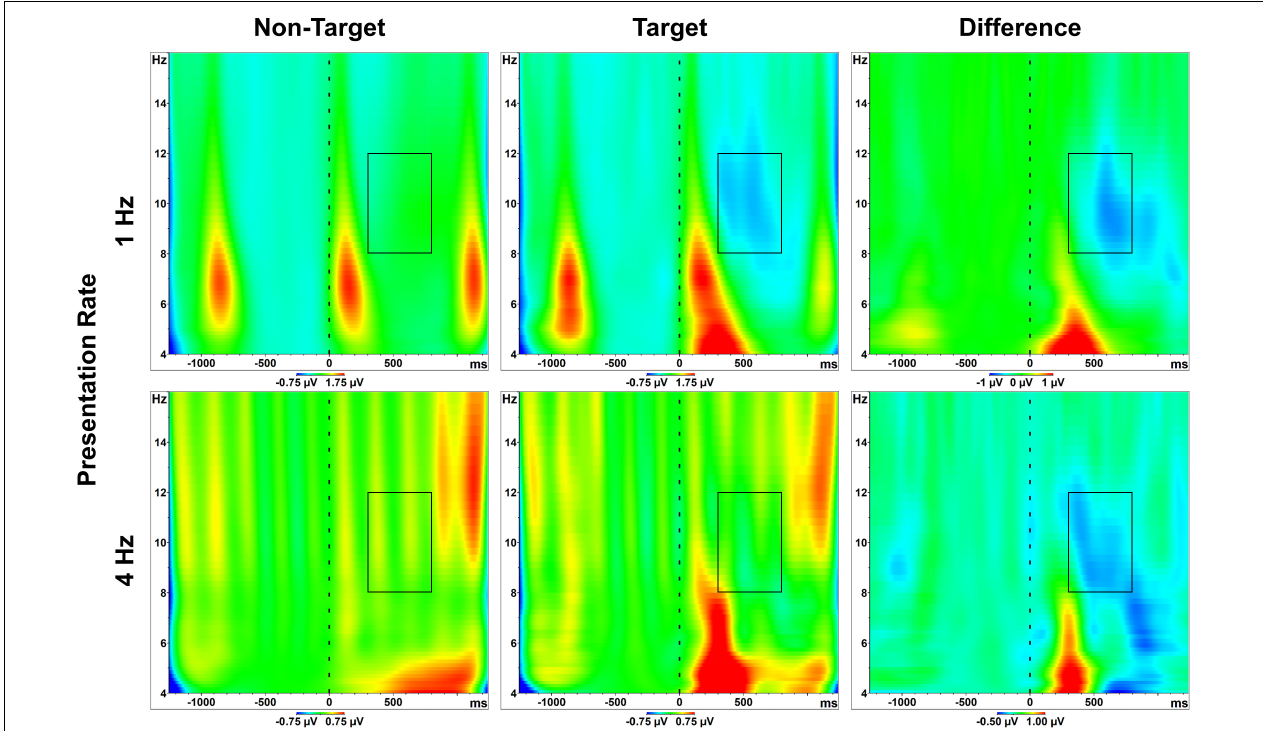
FIGURE 3 | Scaleograms. Spectra 4–16 Hz, relative to stimulus onset ( t = 0). Plots are derived from pooled posterior sites, averaged across all participants, and separated by condition (presentation rate; stimulus class). Boxes represent the alpha band (8–12 Hz) and the measured effect window. The final column illustrates the alpha attenuation effect, or the difference in activity between target and non-target letter responses. SSVEP signatures are visible across conditions, both as conspicuous bursts in the range of 5–9 Hz (the 1 Hz presentation condition), and as more spectrally-diffuse vertical stripes (the 4 Hz presentation condition). A clear increase in theta activity is also visible approximately 200–300 ms following target stimuli. Color scaling is consistent between targets/non-targets within presentation rate conditions. However, due to gross differences in alpha activity between the 1 Hz and 4 Hz conditions (see Figure 4 , which includes static scaling of axes across conditions), scaling was adjusted to better highlight the time-course of the attenuation effect.